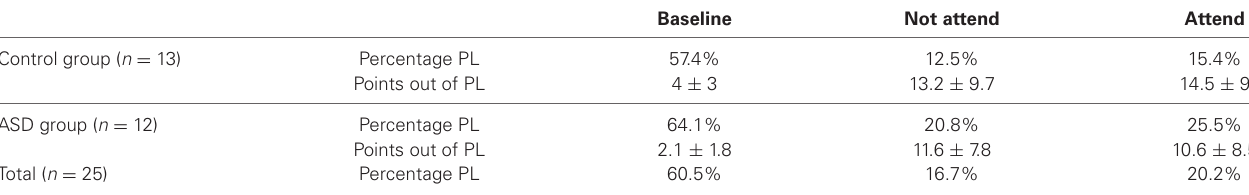
Table 1 | Presence of tail power law (PL) regimes in the distribution of the synchronization index during the auditory attention task .